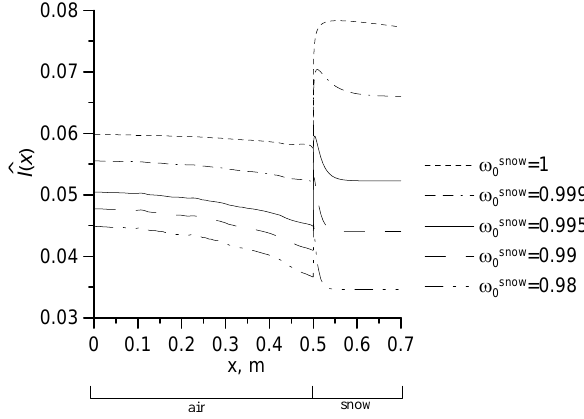
Fig. 9. Relative intensity ˆ I(x) in the zenith direction (cid:127) ∗ at the top boundary CS of the homogeneous snowpack. Width D = 1m, depth H = 0 . 7m and no black film, for the different single scattering albe- dos ω snow . 0